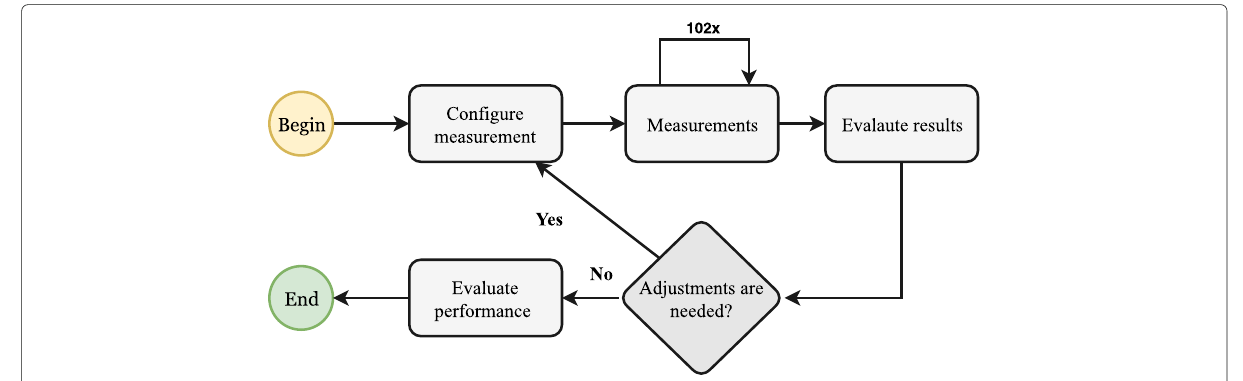
Fig. 12 Methodology for performing measurements with the